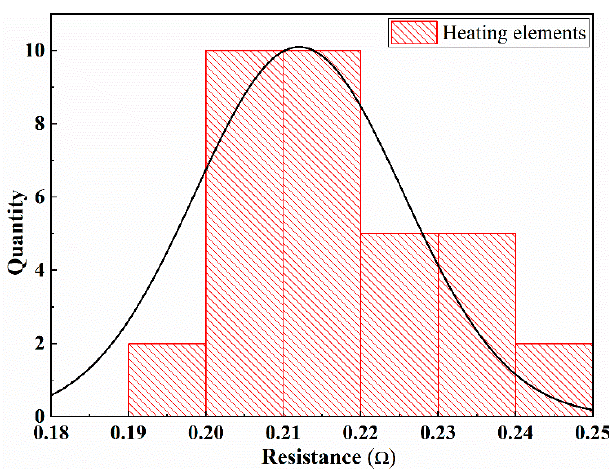
Figure 1. Stainless steel mesh heating elements.